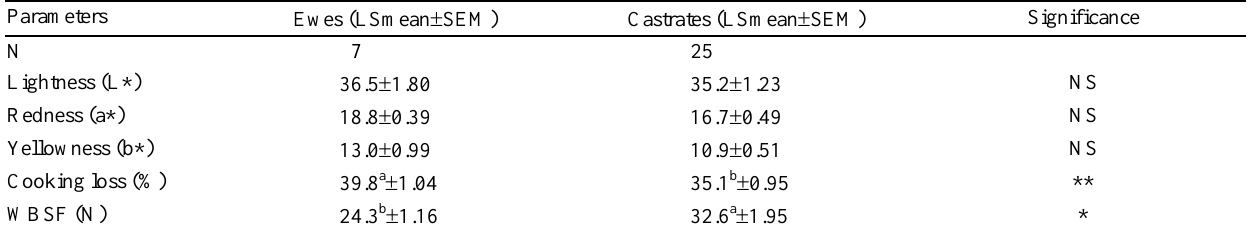
Table 4. The effect of animal gender on the colour (L* a* b*), cooking loss and tenderness of mutton Parameters